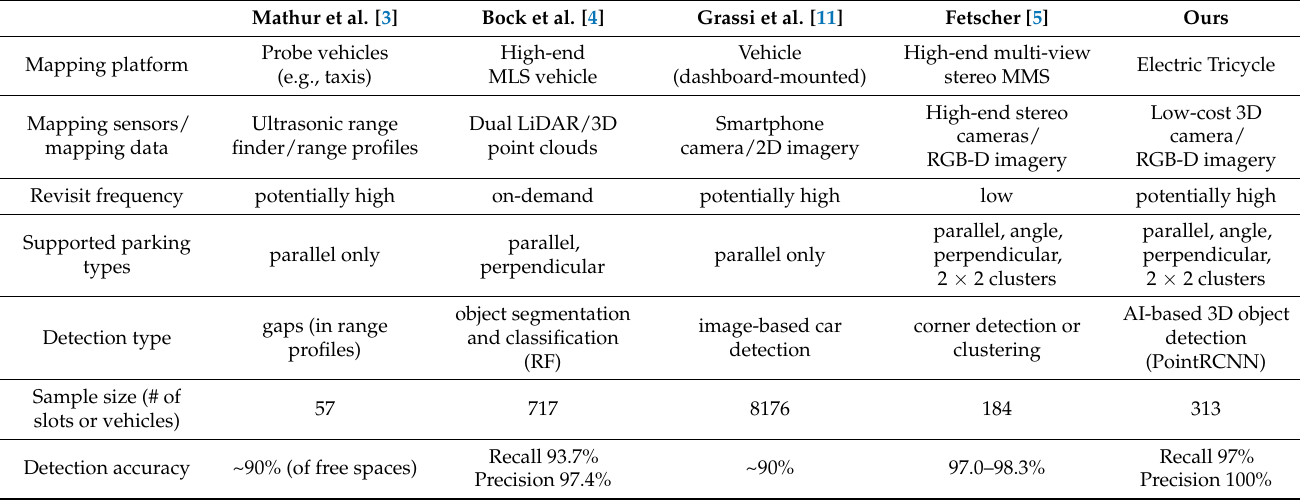
Table 5. Comparison of our method with the main methods for deriving on-street parking statistics from mobile